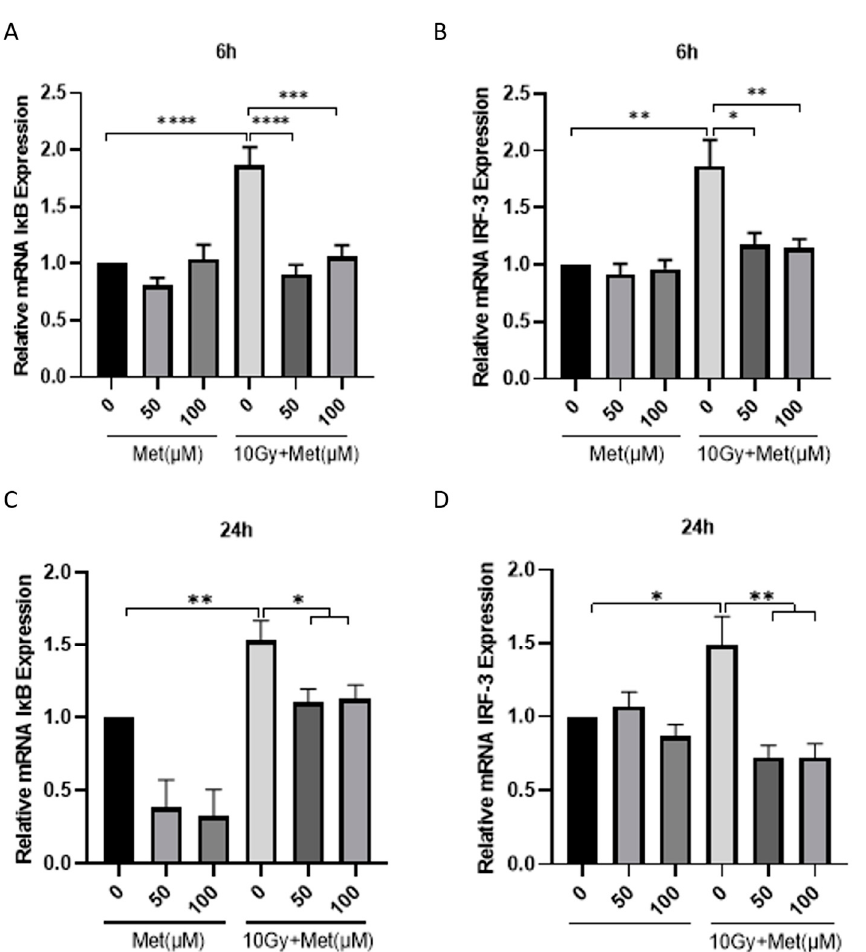
Figure 6. Metformin reduces the mRNA levels of I κ B and IRF-3 in BV2 cells. ( A , B ) The mRNA expression levels of I κ B ( A ) and IRF-3 ( B ) at the 6th hour (h) after 10 Gy irradiation. ( C , D ) The mRNA expression levels of I κ B ( C ) and IRF-3 ( D ) at the 24th h after 10 Gy irradiation. Met, metformin. * p < 0.05, ** p < 0.01, *** p < 0.001, **** p < 0.0001.